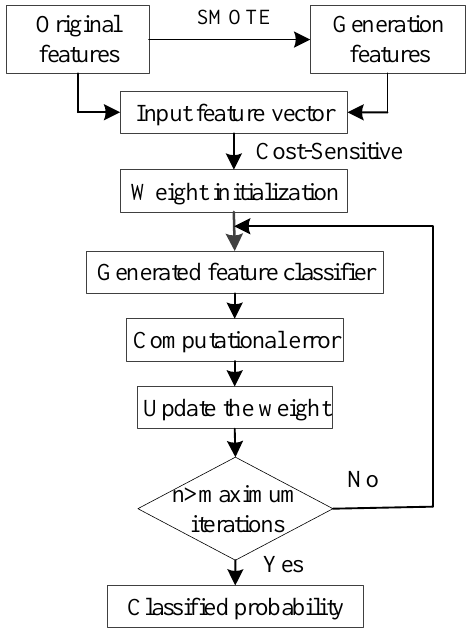
Figure 6. Flowchart of the dynamic attribute-guided augmentation (DAGA)